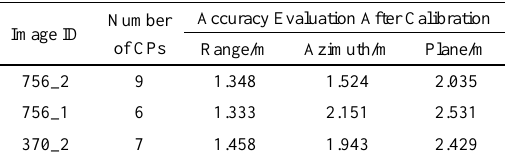
Table 4. Accuracy evaluation of study images after the geometric calibration